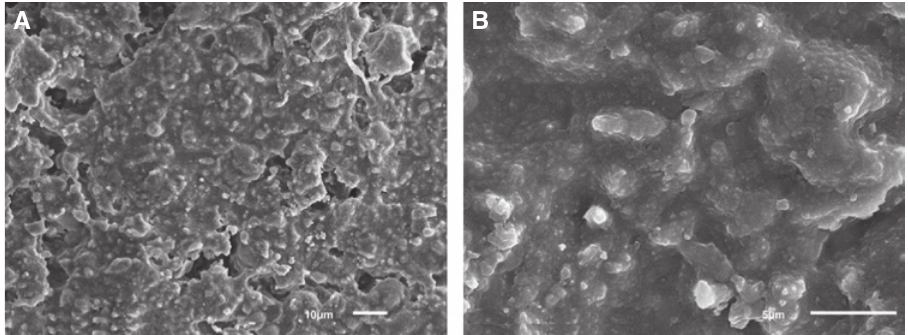
Figure 15: Surface morphology of E900 taken at different magnifications (A) × 1000 and (B) ×